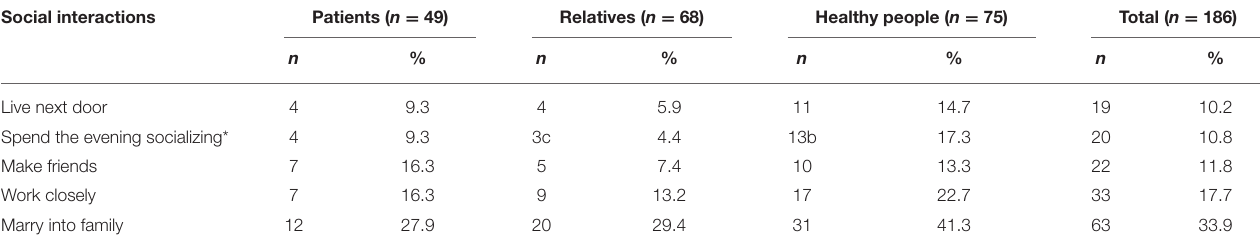
TABLE 4 | Compared on each statement about social distance toward the person in vignette. Social